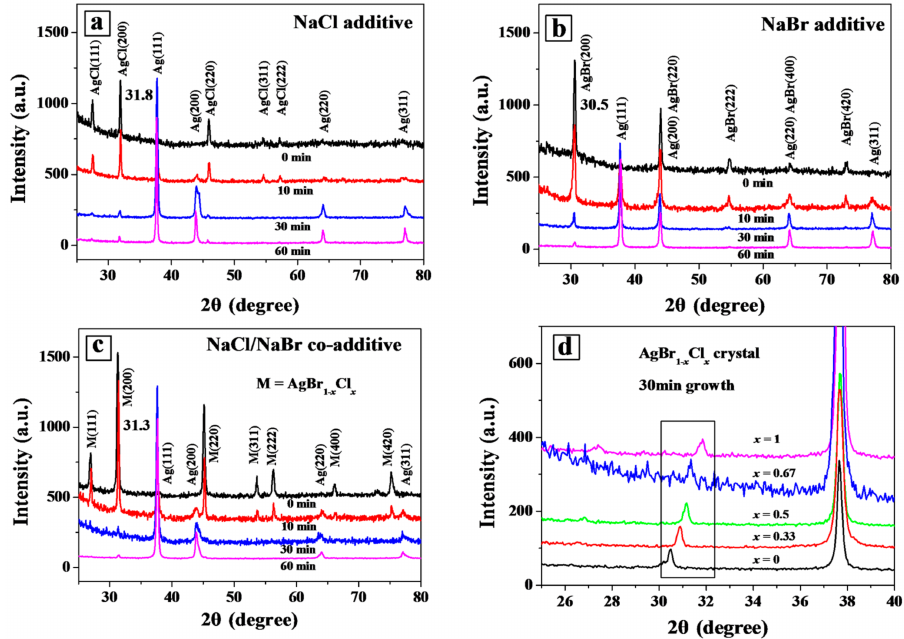
Figure 2. XRD patterns of samples obtained with NaCl ( a ), NaBr ( b ) and NaCl/NaBr ( c ) additives at different growth time. The diffraction peaks at 31.8 ◦ , 30.5 ◦ and 31.3 ◦ was observed from the AgCl, AgBr and AgBr 1 − x Cl x crystals, respectively. ( d ) Shifted diffraction peaks in AgBr 1 − x Cl x crystals synthesized with different molar ratio of x =